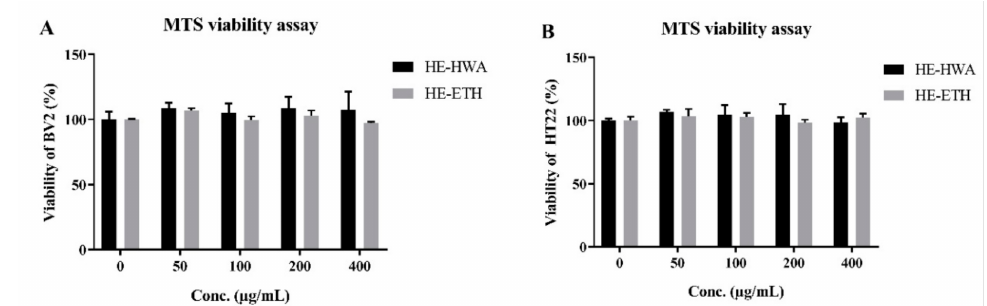
Figure 2. Cytotoxicity of hot water (HE-HWA) and ethanolic (HE-ETH) extracts on ( A ) BV-2 microglia and ( B ) HT22 neurons. The results were expressed as percentage of viable cell versus control, with control considered as 100% cell viability. All values presented correspond to mean ± SD of three independent experiments ( n =